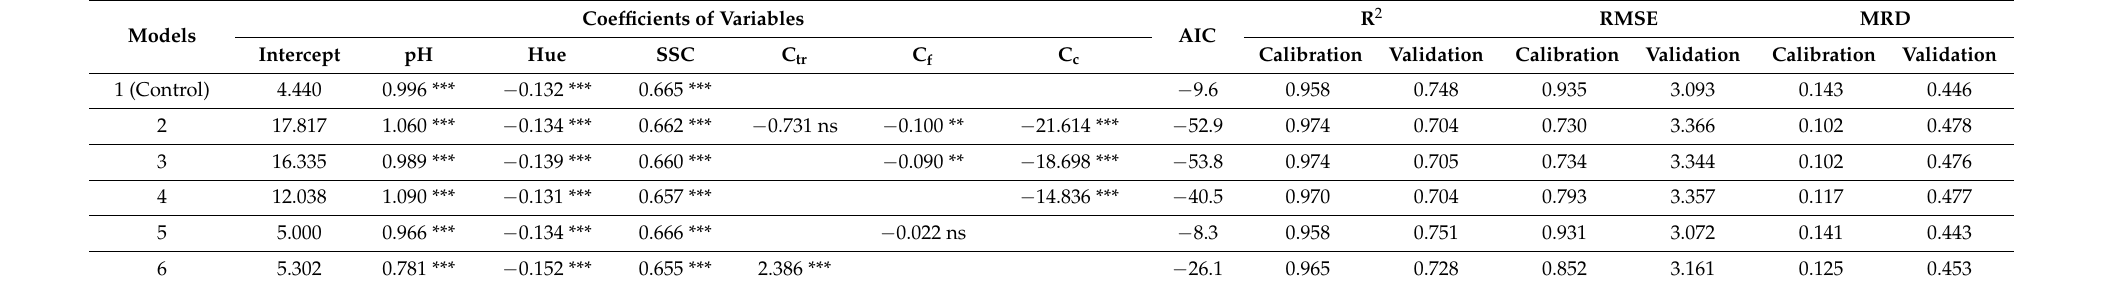
Table 4. Model coefficients and parameters for multi-varietal prediction of mango ripening by multi-linear